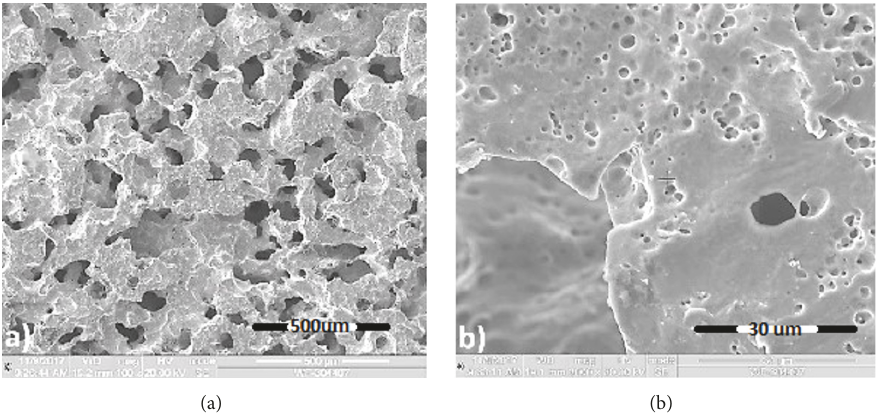
Figure 4: SEM survey of combustion synthesis porous Nitinol at (a) 100X and (b) 1000X magnification.